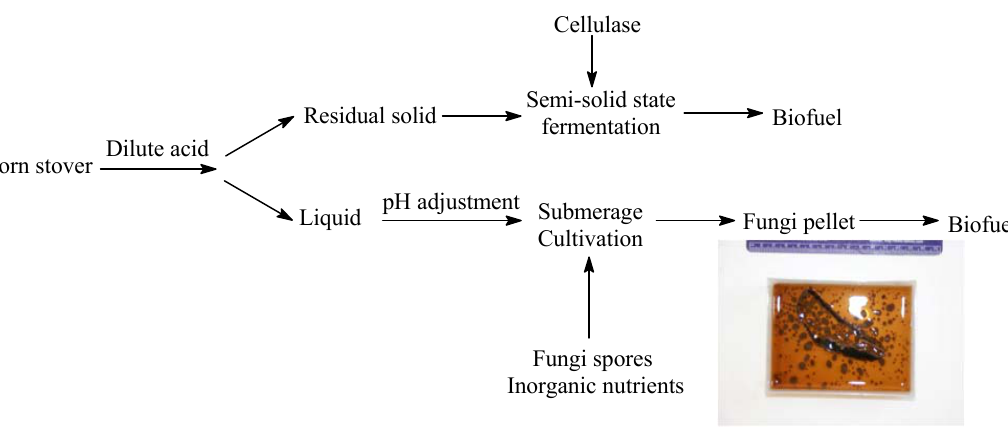
Figure 2. Application of pelletized filamentous fungal